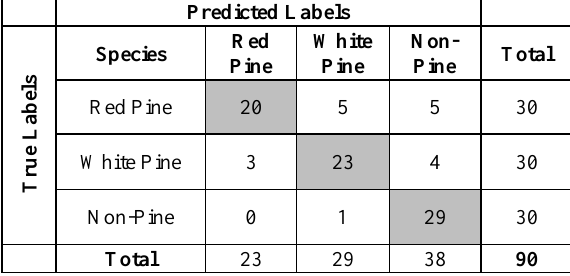
Table 3. Confusion matrix for species classification using data